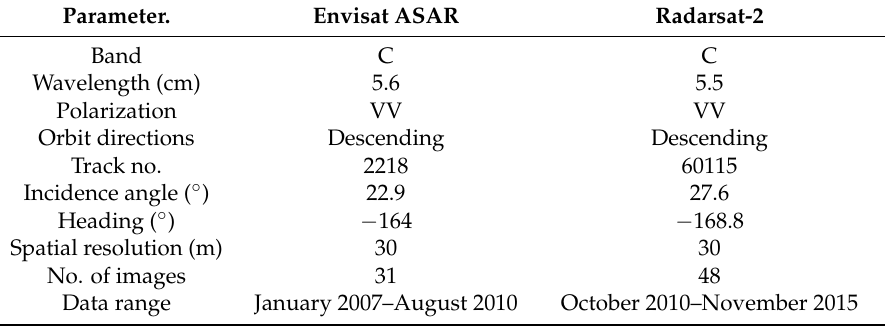
Table 1. The parameters of the interferometric synthetic aperture radar (In-SAR) data used. Parameter. Envisat ASAR Radarsat-2 Band C C Wavelength (cm) 5.6 5.5 Polarization VV VV Orbit directions Descending Descending Track no. 2218 60115 Incidence angle ( ◦ ) 22.9 27.6 Heading ( ◦ ) − 164 − 168.8 Spatial resolution